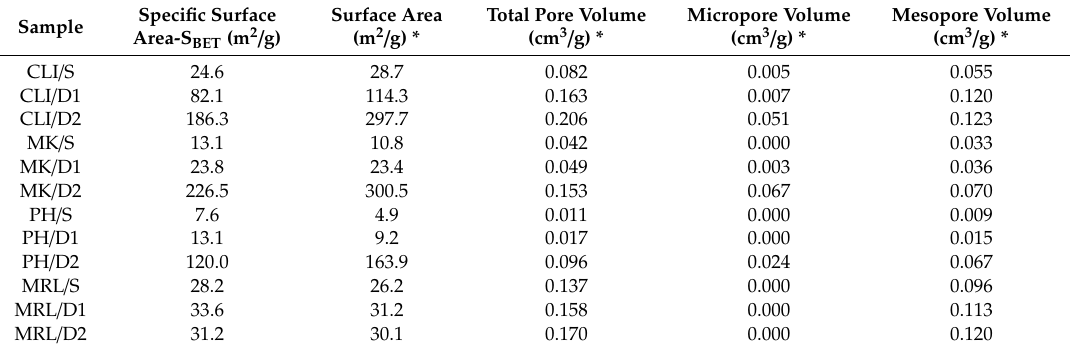
Figure 3. Nitrogen adsorption and desorption isotherms of clinoptilolite ( a ), metakaolin ( b ), phonolite ( c ) and marlstone ( d ). Table 1. Textural properties of clinoptilolite, metakaolin, phonolite, marlstone determined by N2 physisorption